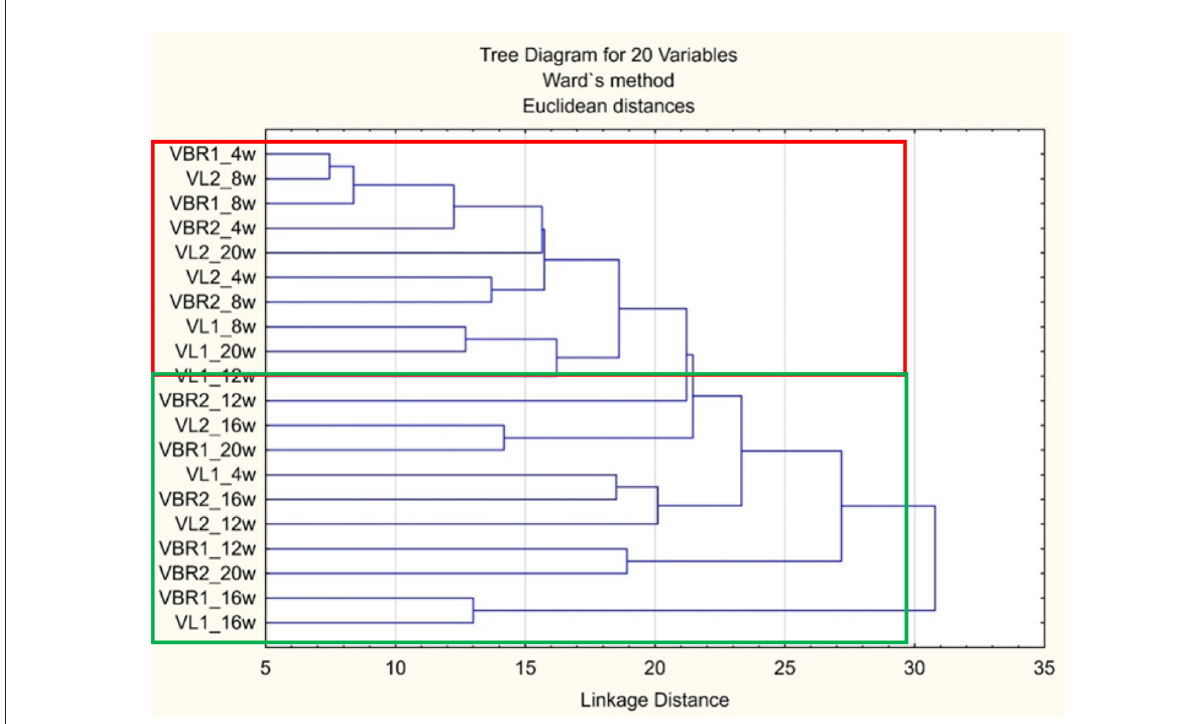
FIGURE3 Dendrogram illustrating the differences in microbial functional diversity between different soil samples of landraces and growth stages over